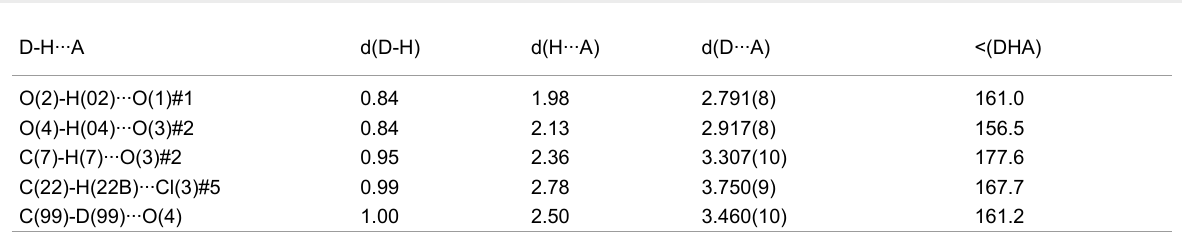
Table 1: Hydrogen bonds [Å and °] for 12 . CDCl 3 . a